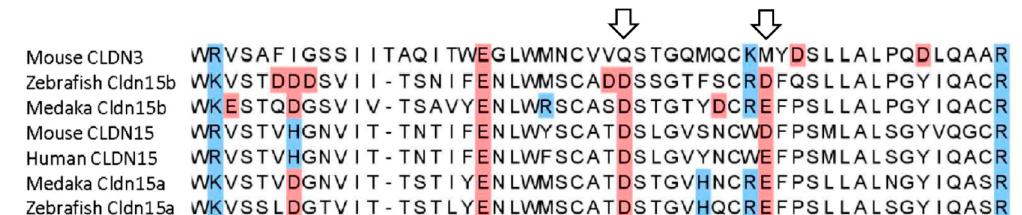
be investigated in future studies.